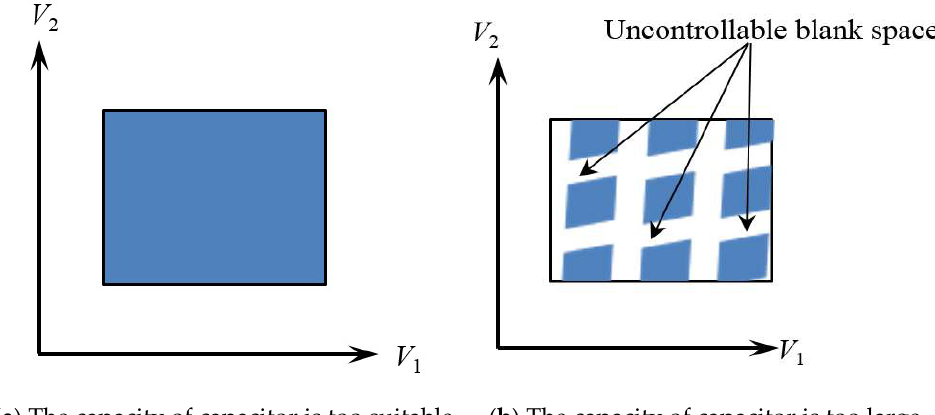
Figure 10. 2-dimensional plane projection of voltage security region.